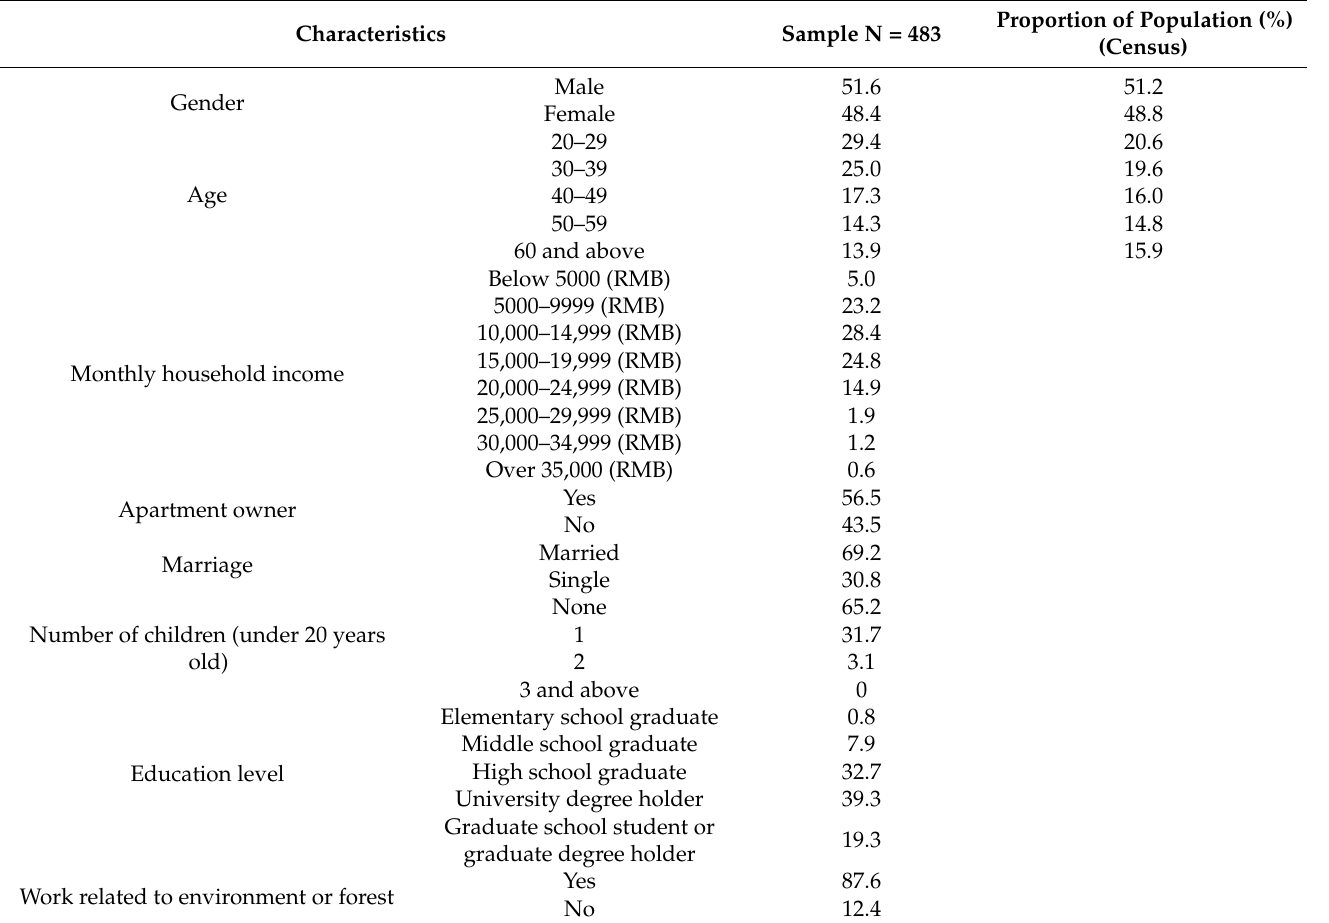
Table 10. Descriptive statistics of respondents’